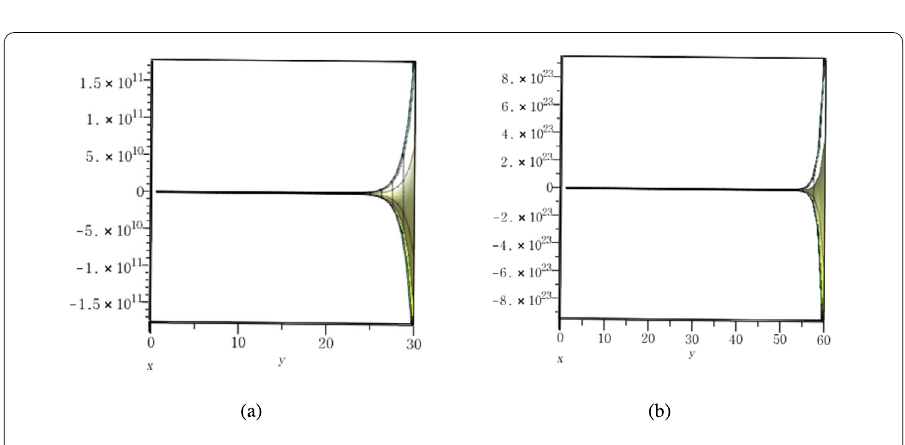
Figure 8 Figures showing the size of the remainder term of D sin( p ) according to the range of x = S p and y = | V p | using Maple 20 performance. ( a ) Output of Maple 20 Plot3d of 1 x = –10 ··· 10, y = 0 ··· 10. For x within a certain interval, as the size of y decreases, the remainder term